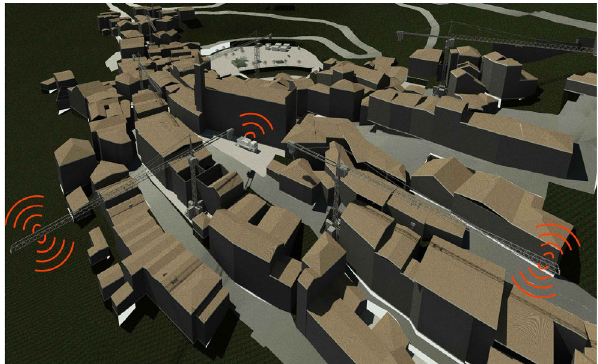
Figure 1. Rendered view. The figure represents the BIM model of Fossa with the preparations for the construction site (crane, common storage area,